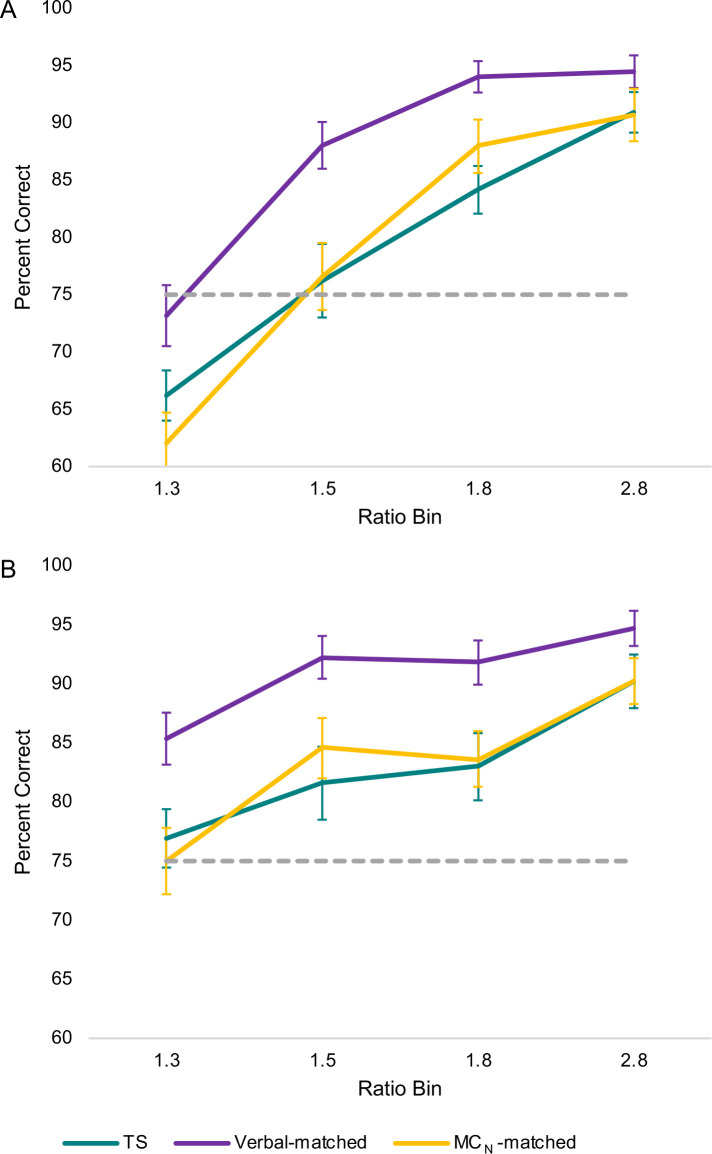
Mean MCN accuracy by size control, across ratio bin (Ratio of dot arrays).Panel A shows accuracy (percent correct) when dots were size-controlled (the more numerous and less numerous sides had the same total number of pixels). Panel B shows percent correct when dots were not size-controlled (the more numerous side had more dots and more total pixels than the less numerous side). Reliably accurate magnitude comparison, which we define as accuracy at or above the 75% threshold, is marked by the dotted line. Error bars represent standard error of the mean. Data include n = 39 children with TS, n = 41 Verbal-matched children, and n = 40 MCN-matched children.